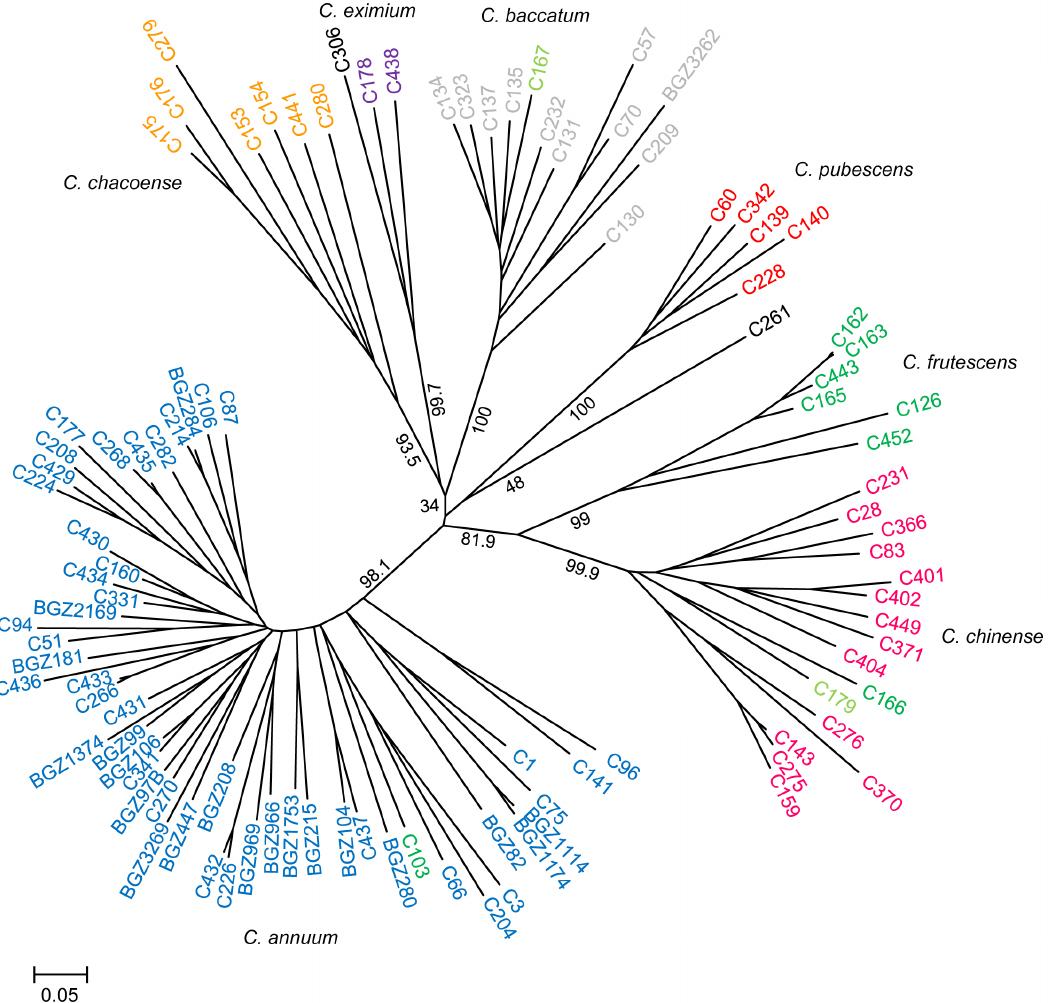
Fig. 1. NJ tree of 102 Capsicum accessions based on 39 SSR markers. Only bootstrap values that supported each species or complex have been printed. Numbers are the percentage of bootstrap support. C. cardenasii C306 and C. tovarii C261 are represented in black. C. galapagoense accessions C167 and C179 are shown in light